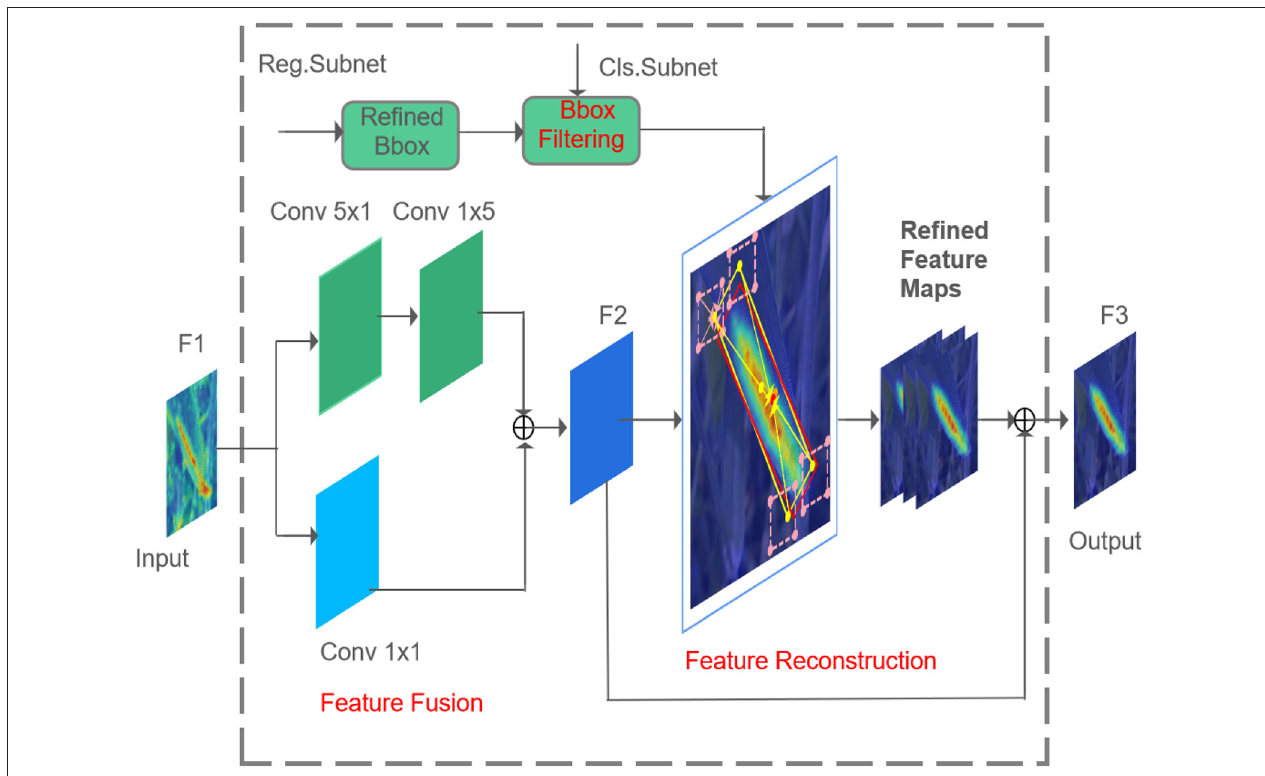
FIGURE 9 | Feature refinement